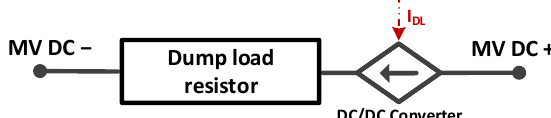
Figure 7. Computational model for the dump-load.